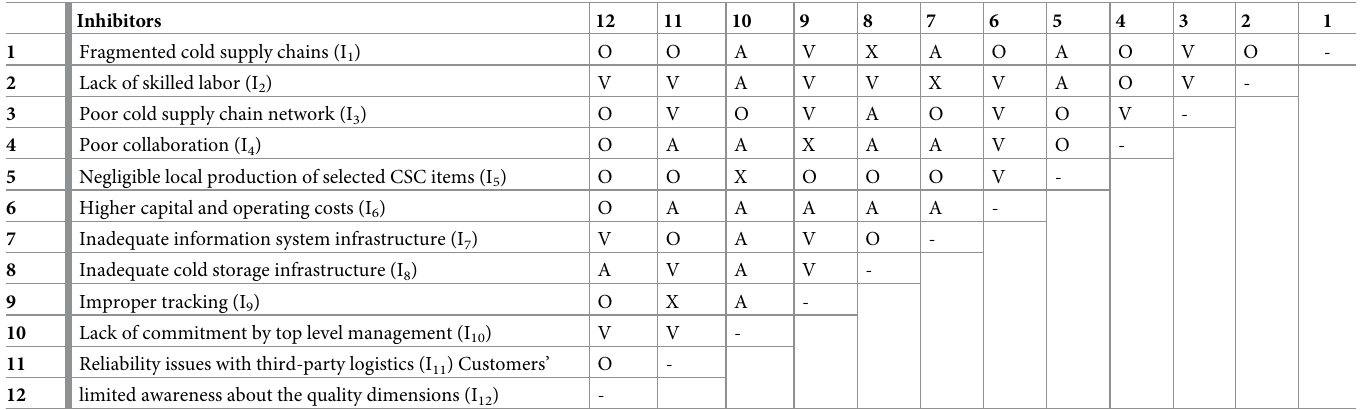
Table 2. Structural self-interaction matrix